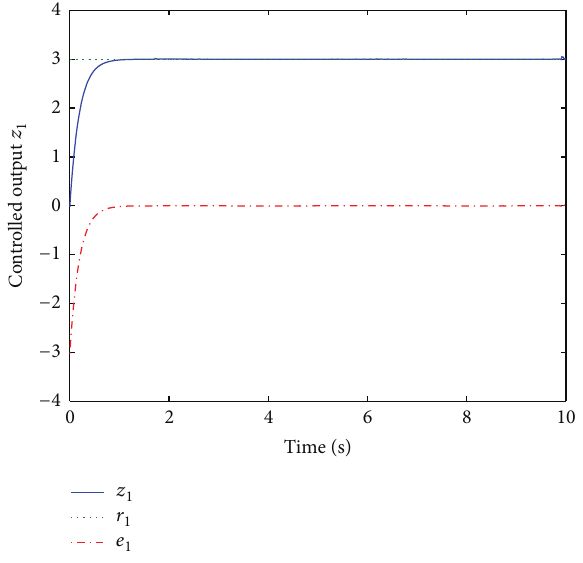
Figure 2: Controlled output 𝑧 1 and tracking error 𝑒 1 .